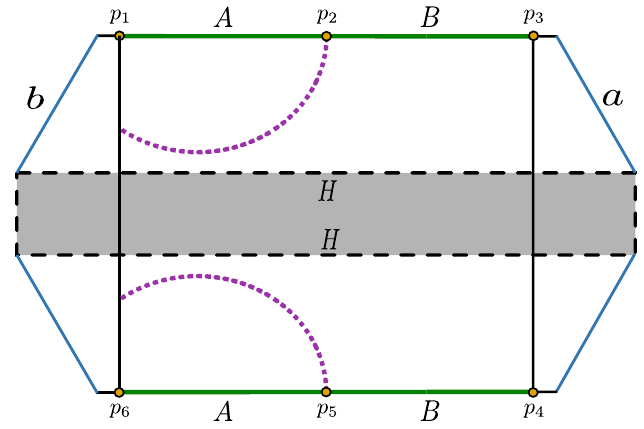
Figure 13 . The points in the two BCFT 2 copies are identified as p 1 = r I + (cid:15) , p 6 = r I + (cid:15) p 2 = r 1 , p 5 = r 1 , p 3 = r O − (cid:15) and p 4 = r O − (cid:15)